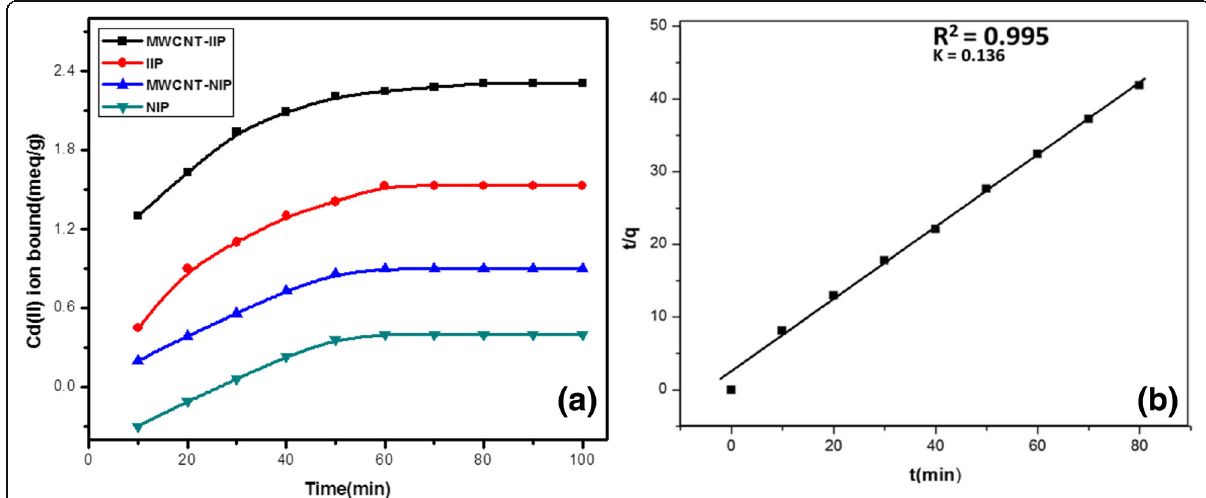
Fig. 17 a Effect of time on the adsorption of Cd(II) ion on MWCNT-IIP, IIP, MWCNT-NIP, and NIP. b Pseudo-second-order kinetics for the adsorption of Cd(II) ion on